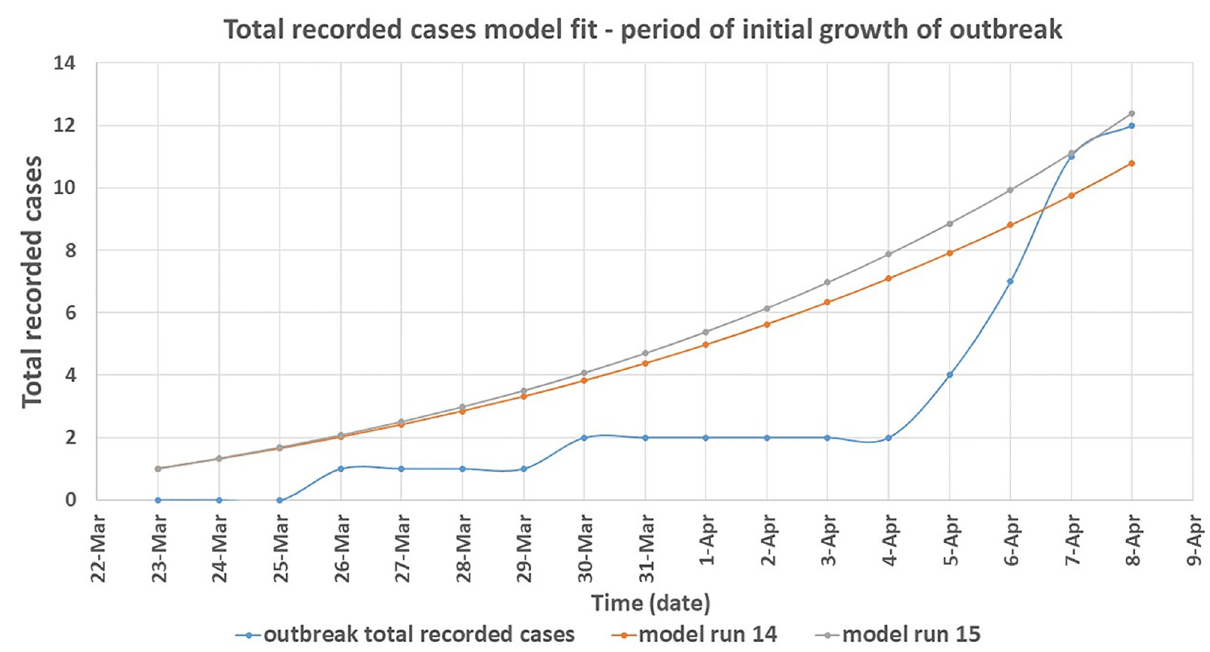
Fig 6. Derived SIR model simulation showing the model fit for runs 14 and 15 to the total (cumulative) number of recorded cases over time during the period of initial rise of cases for Nyimba bubonic plague outbreak. Goodness of fit: run 14 (P-value 0.202), run 15 (P-value 0.064).